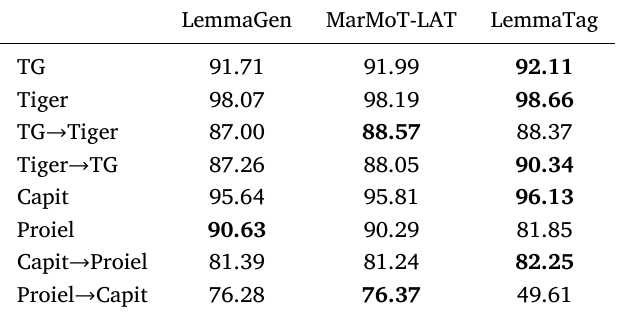
Direct lemmatization accuracy in